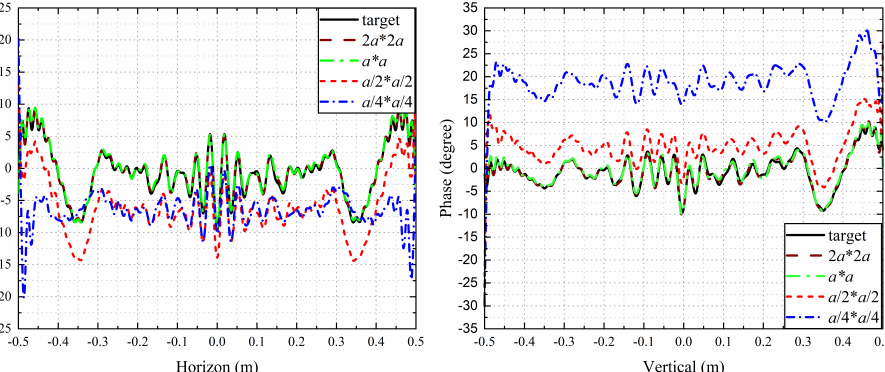
Figure 15. The comparison between the target phase and the phase retrieved by the proposed algorithm with the sampling area of the plane S 2 reduced in different